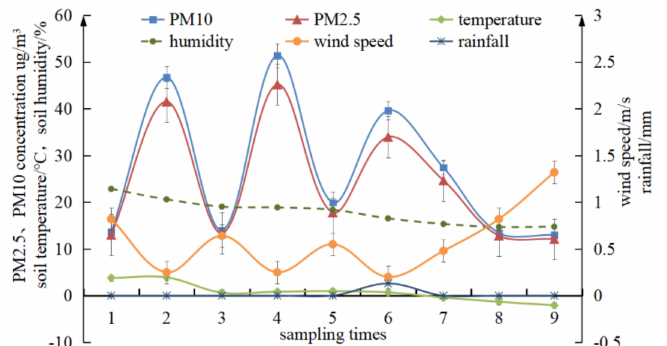
Figure 15. Miyun straw burial.